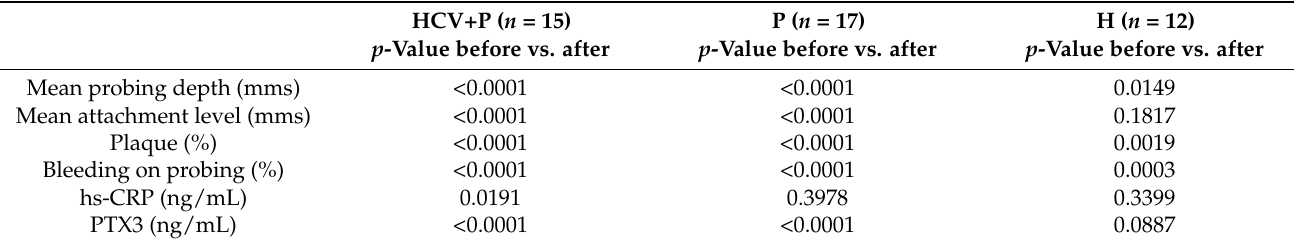
Table 3. Differences between characteristics before vs. after treatment.